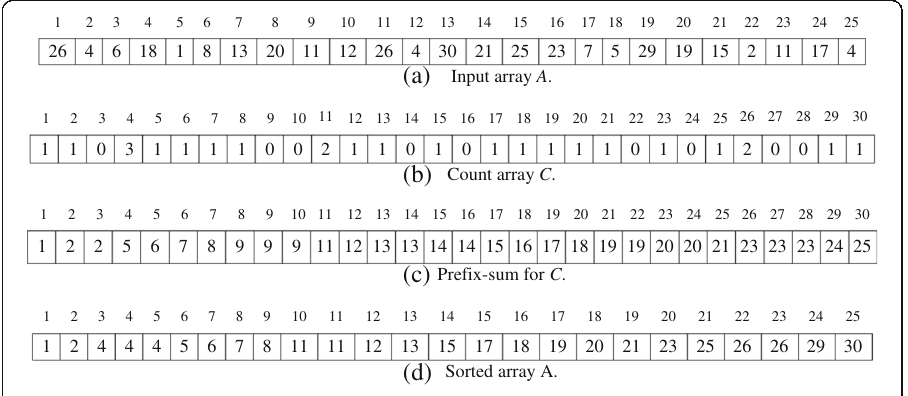
(d) Sorted array A. Fig. 2 Tracing of the CS algorithm in case of O ( m ) = O ( n ). a Input array A . b Count array C . c Prefix-sum for C . d Sorted array